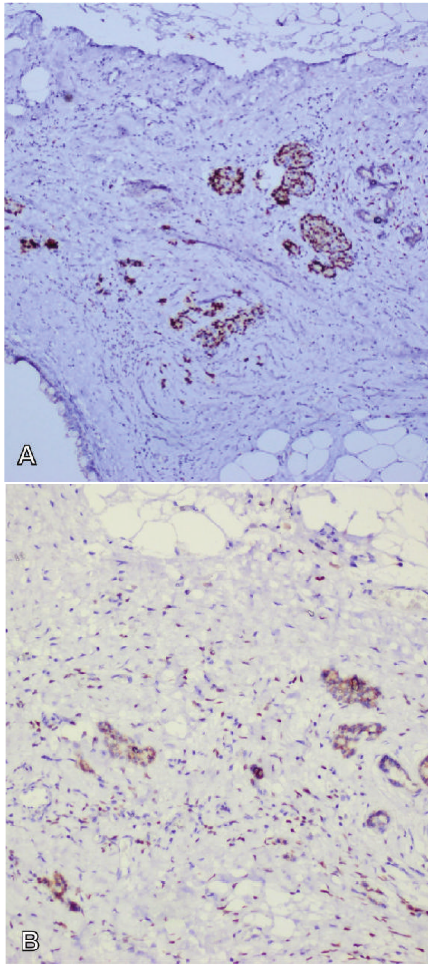
Figure 3: (A) Immunohistochemical PR-positive glandular struc- tures and (B) immunohistochemical ER-positive glandular struc- tures were seen on image ( ×